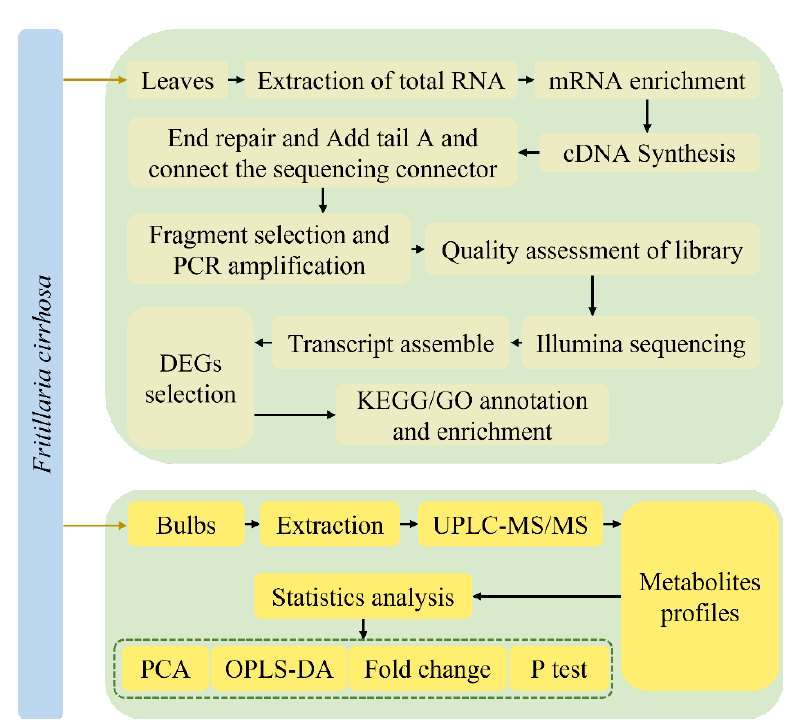
Figure 1. The experimental flow chart.